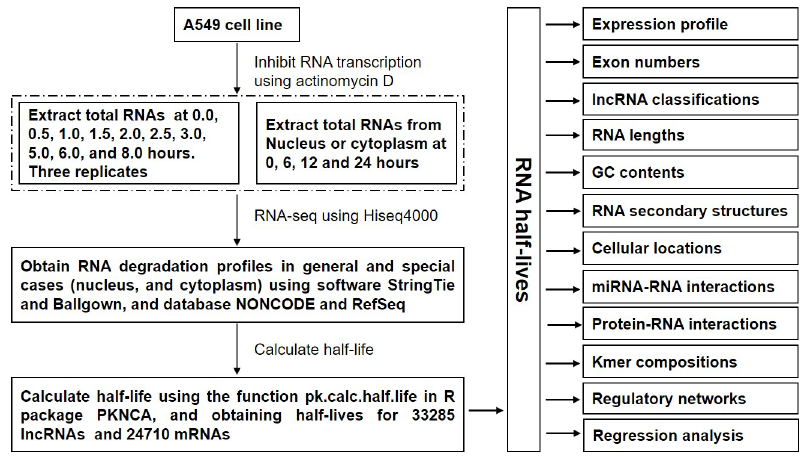
Fig 1. Flowchat for the whole experiments and data